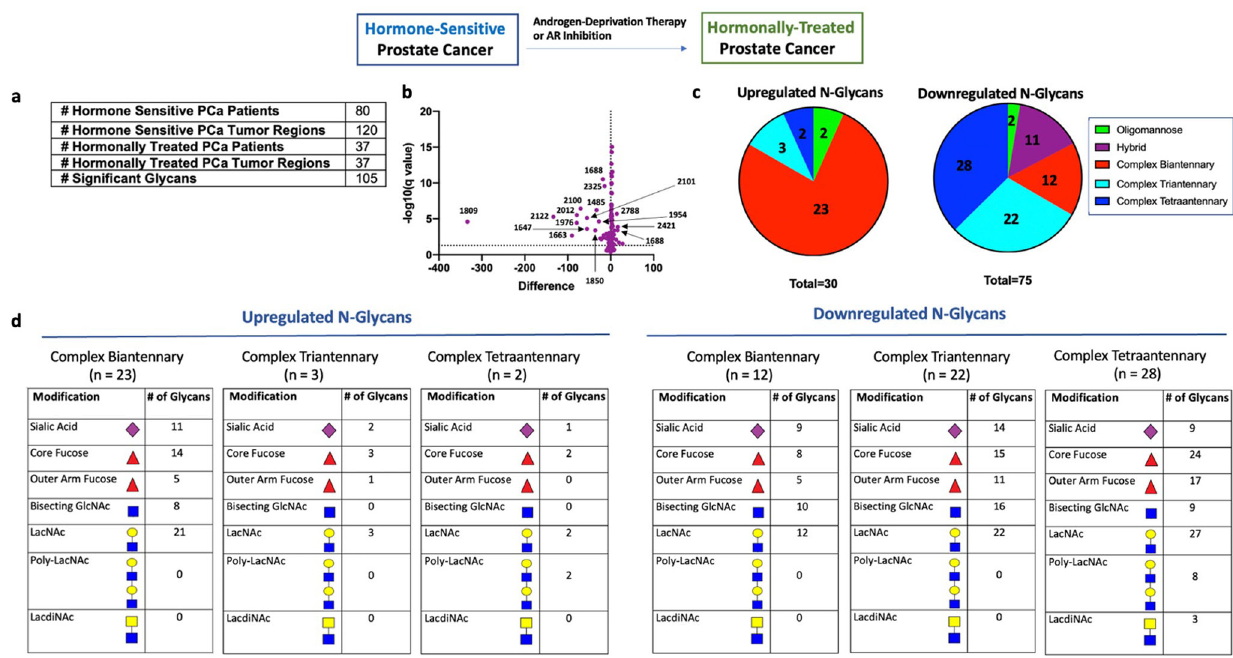
Fig. 3 N-linked glycosylation changes in hormonally-treated tumors. a Table demonstrating number of hormone-sensitive and hormonally- treated PCa patients studied, the number of annotated tumor regions within each group, and number of signi fi cant glycans between all hormone-sensitive regions ( n = 120) and all hormonally-treated regions ( n = 37). b Volcano plot comparison of all glycans in annotated hormone sensitive PCa tumor regions ( n = 120) and annotated hormonally-treated PCa tumor regions ( n = 37). 105/150 glycans detected demonstrate statistical signi fi cance between the two groups with 30 structures upregulated and 75 structures downregulated. c Circle graph demonstrating the proportion of upregulated and downregulated glycans within each major structural category. Complex biantennary glycans represent the largest proportion of upregulated glycans while complex tri- and tetraantennary glycans represent the largest proportion of downregulated glycans. d Tables demonstrating common structural modi fi cations associated with upregulated and downregulated N -glycans in each major structural class showing a signi fi cant